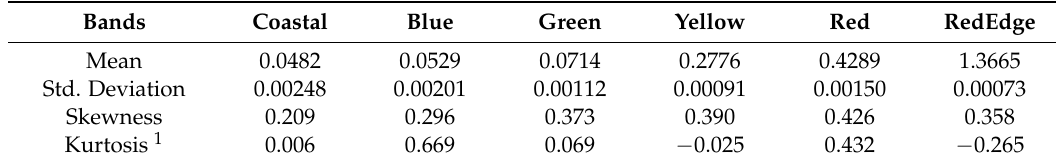
Table 2. Statistics of the Diffuse Attenuation Coefficients (WV-3).